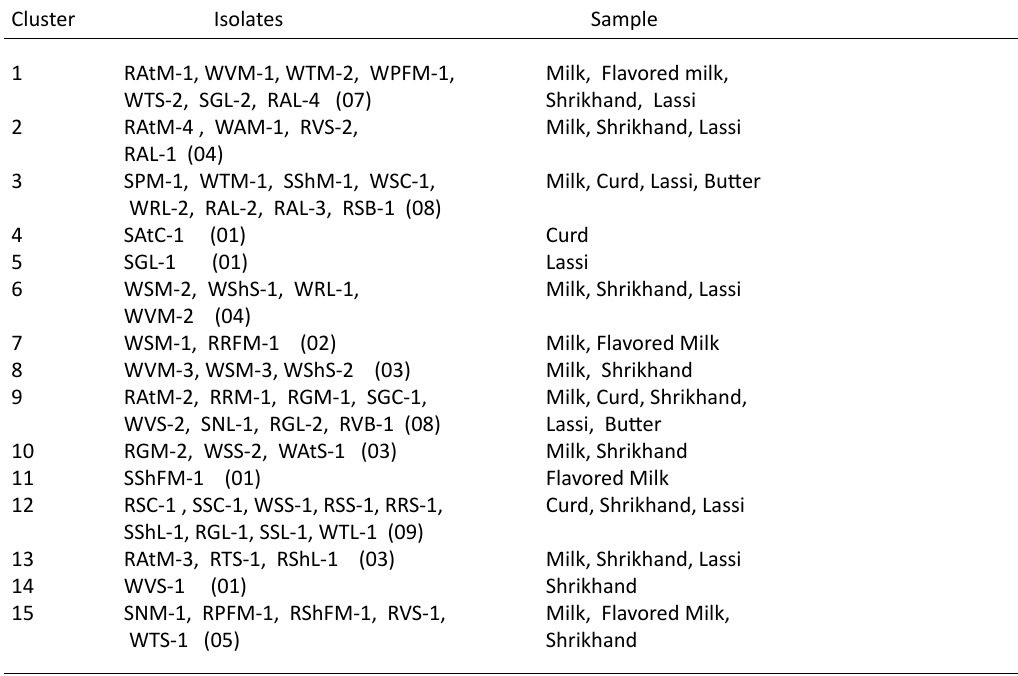
Fig. 11. Phylogenetic analysis of SNM-1 refrigeration temperatures (Guinebretiere et al., 2010). B.cereus causes problems to the food industry both by deteriorating the products and by endangering people’s life upon consuming them (Ghelardi et al., 2002). The storage and transportation of raw milk at low temperatures promote the growth of psychrotrophic bacteria and the production of thermo-stable enzymes, which pose great threats to the quality and shelf- life of dairy products (Yuan et al. 2017) table 4. Clustering of isolates Cluster Isolates